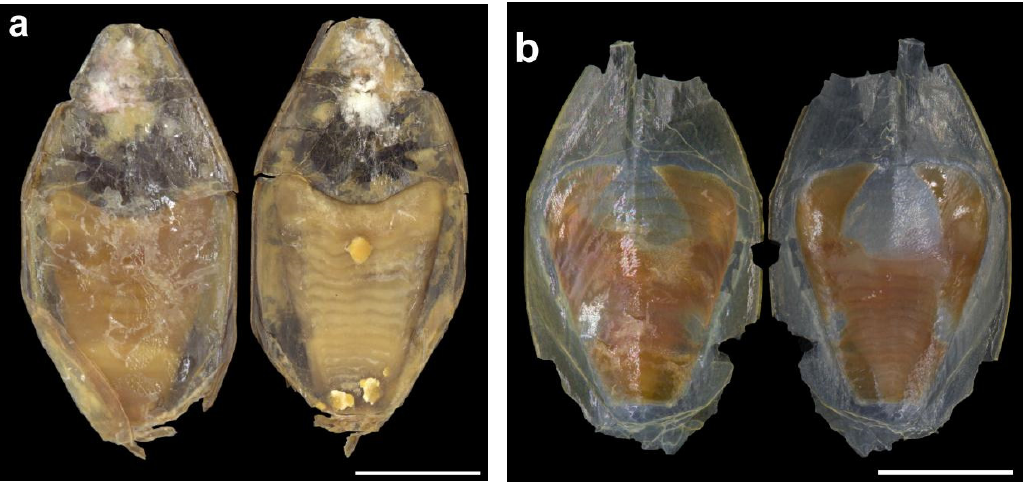
Figure 23. Variability in the cuttlebone of female Sepia typica in dorsal (left) and ventral (right) aspects: ( a ) SAIAB 211600, ML 19 mm; ( b ) SAIAB 211656, ML 19 mm. Scale bars 5 mm. Distribution : Sepia typica is widely distributed (Figure 24), from just north of the Orange River (in southern Namibia) to at least Port Alfred (27° E) on the south-east coast of South Africa, and occurs from shallow waters (4 m [8]) to considerable depths (553 m; this study). It is suspected that the considerable reduction in the calcification of the phragmocone is an adaptation to enable it to live at great depth.